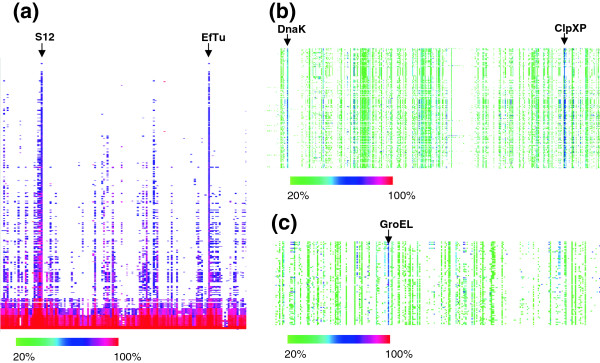
Identification of extremely highly conserved proteins using CodaChrome. (a) A segment of the CodaChrome heat map with Salmonella enterica subsp. enterica serovar Typhimurium 14028S loaded as the seed sequence and the PID threshold set at 75%. Dark pink and red columns representing pair-wise comparisons of proteins S12 and EF-Tu are indicated. (b) Enlargement of a different region of the same CodaChrome heat map as in the previous panel. PID threshold was set to 20%. The dark column on the right represents two adjacent highly conserved proteins ClpX and ClpP. The dark column on the left represents DnaK. (c) Enlargement of another region of the same CodaChrome heat map as in panel a. PID threshold is set to 20%. The region is centered on the highly conserved protein GroEL.